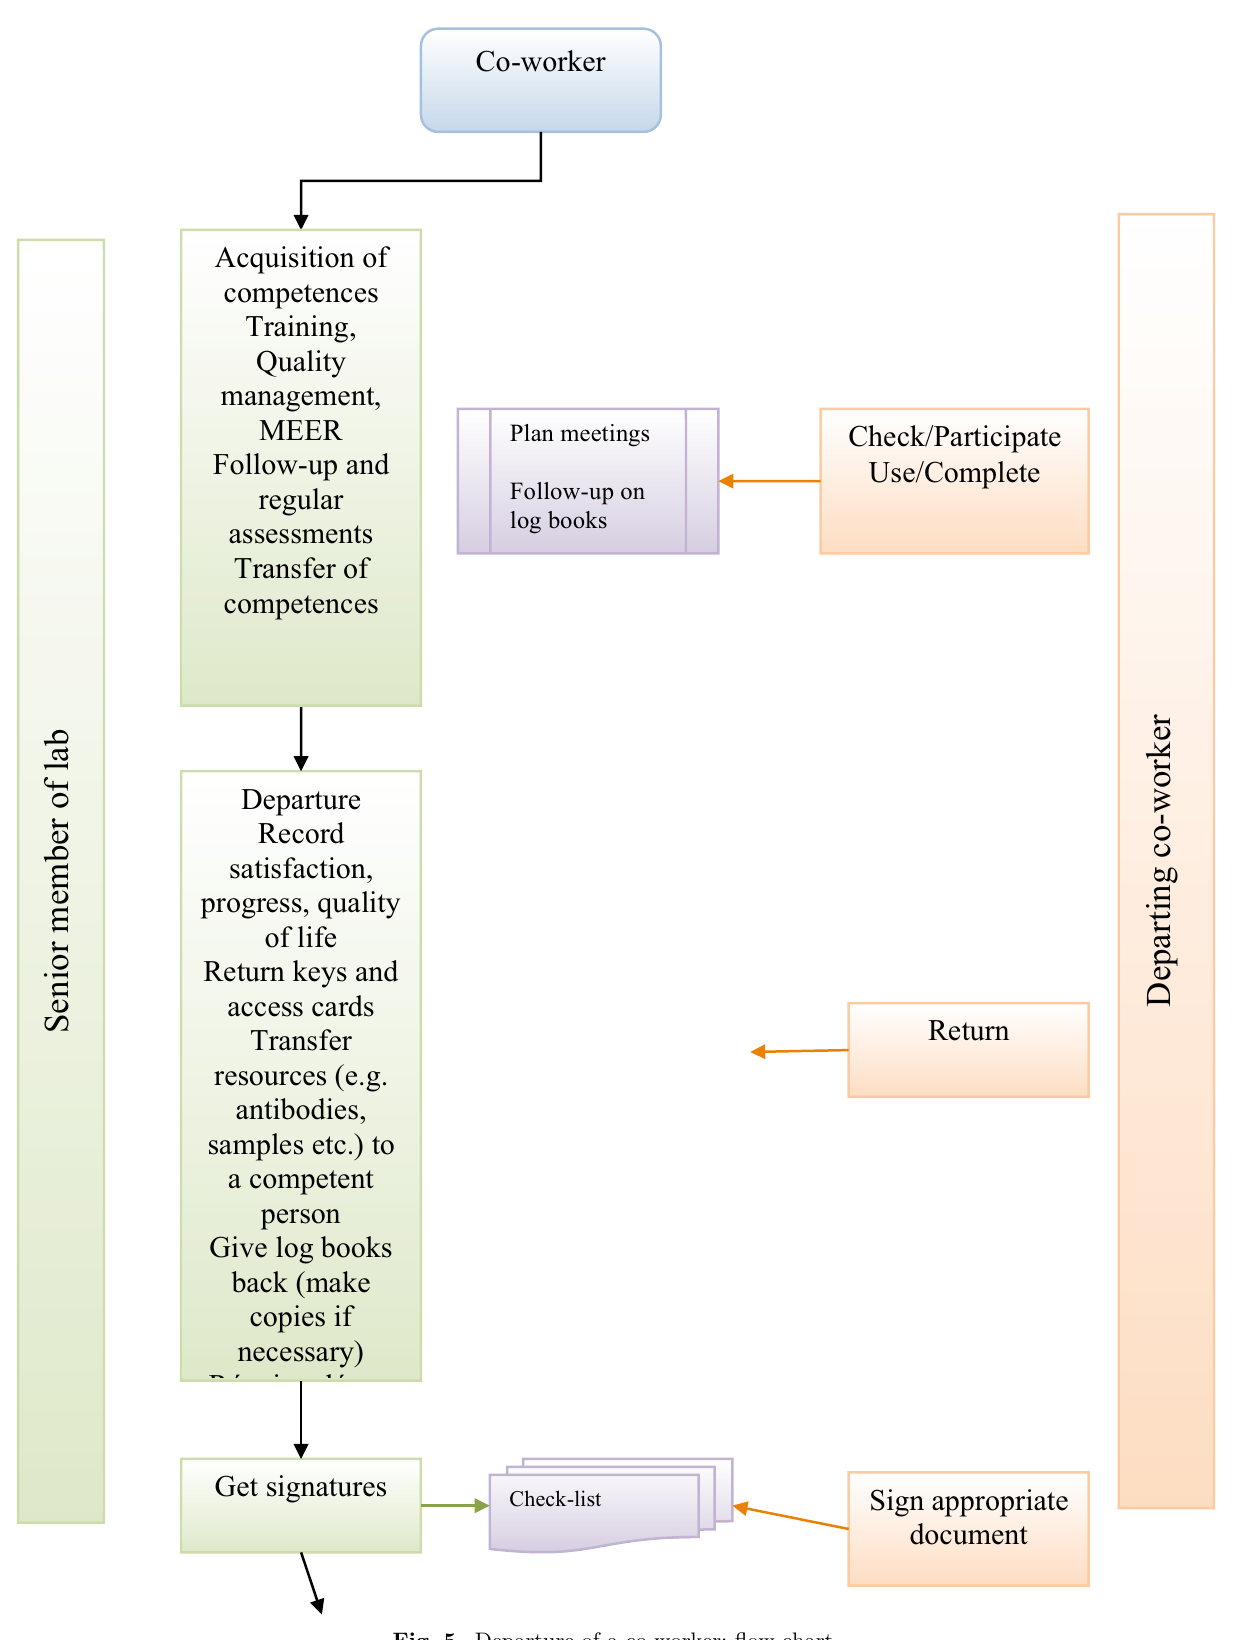
Fig. 5. Departure of a co-worker: fl